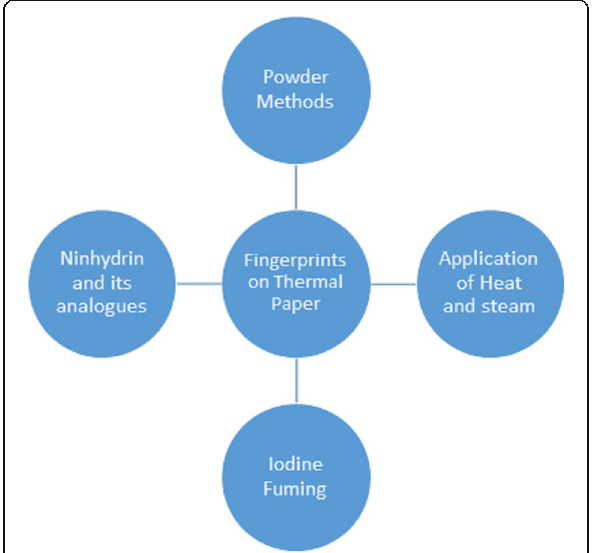
Fig. 1 Different methods used in fingerprint development on thermal